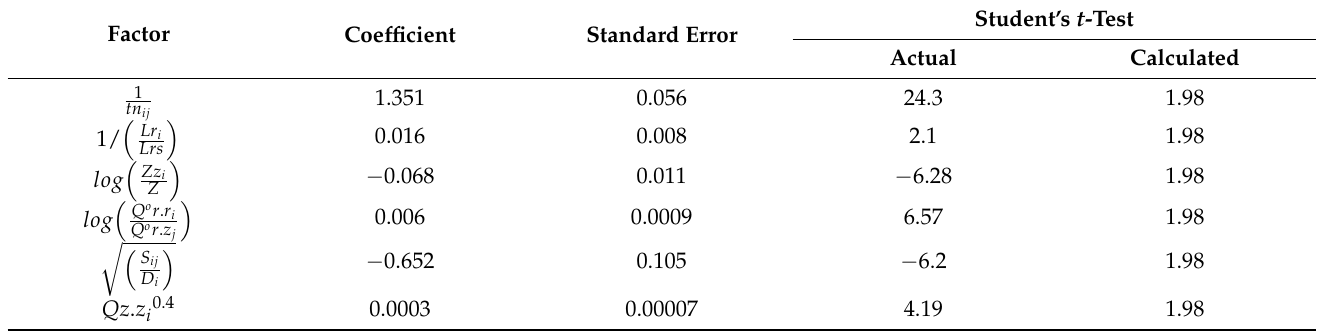
Table 2. Characteristics of the model of the trip distribution function of employees of city-service enterprises.